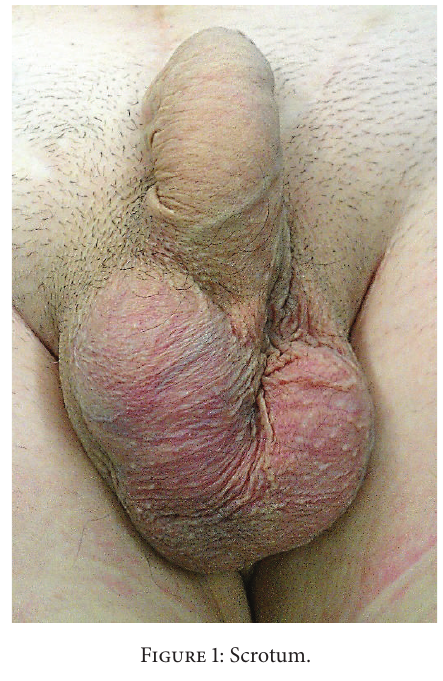
Figure 1: Scrotum.